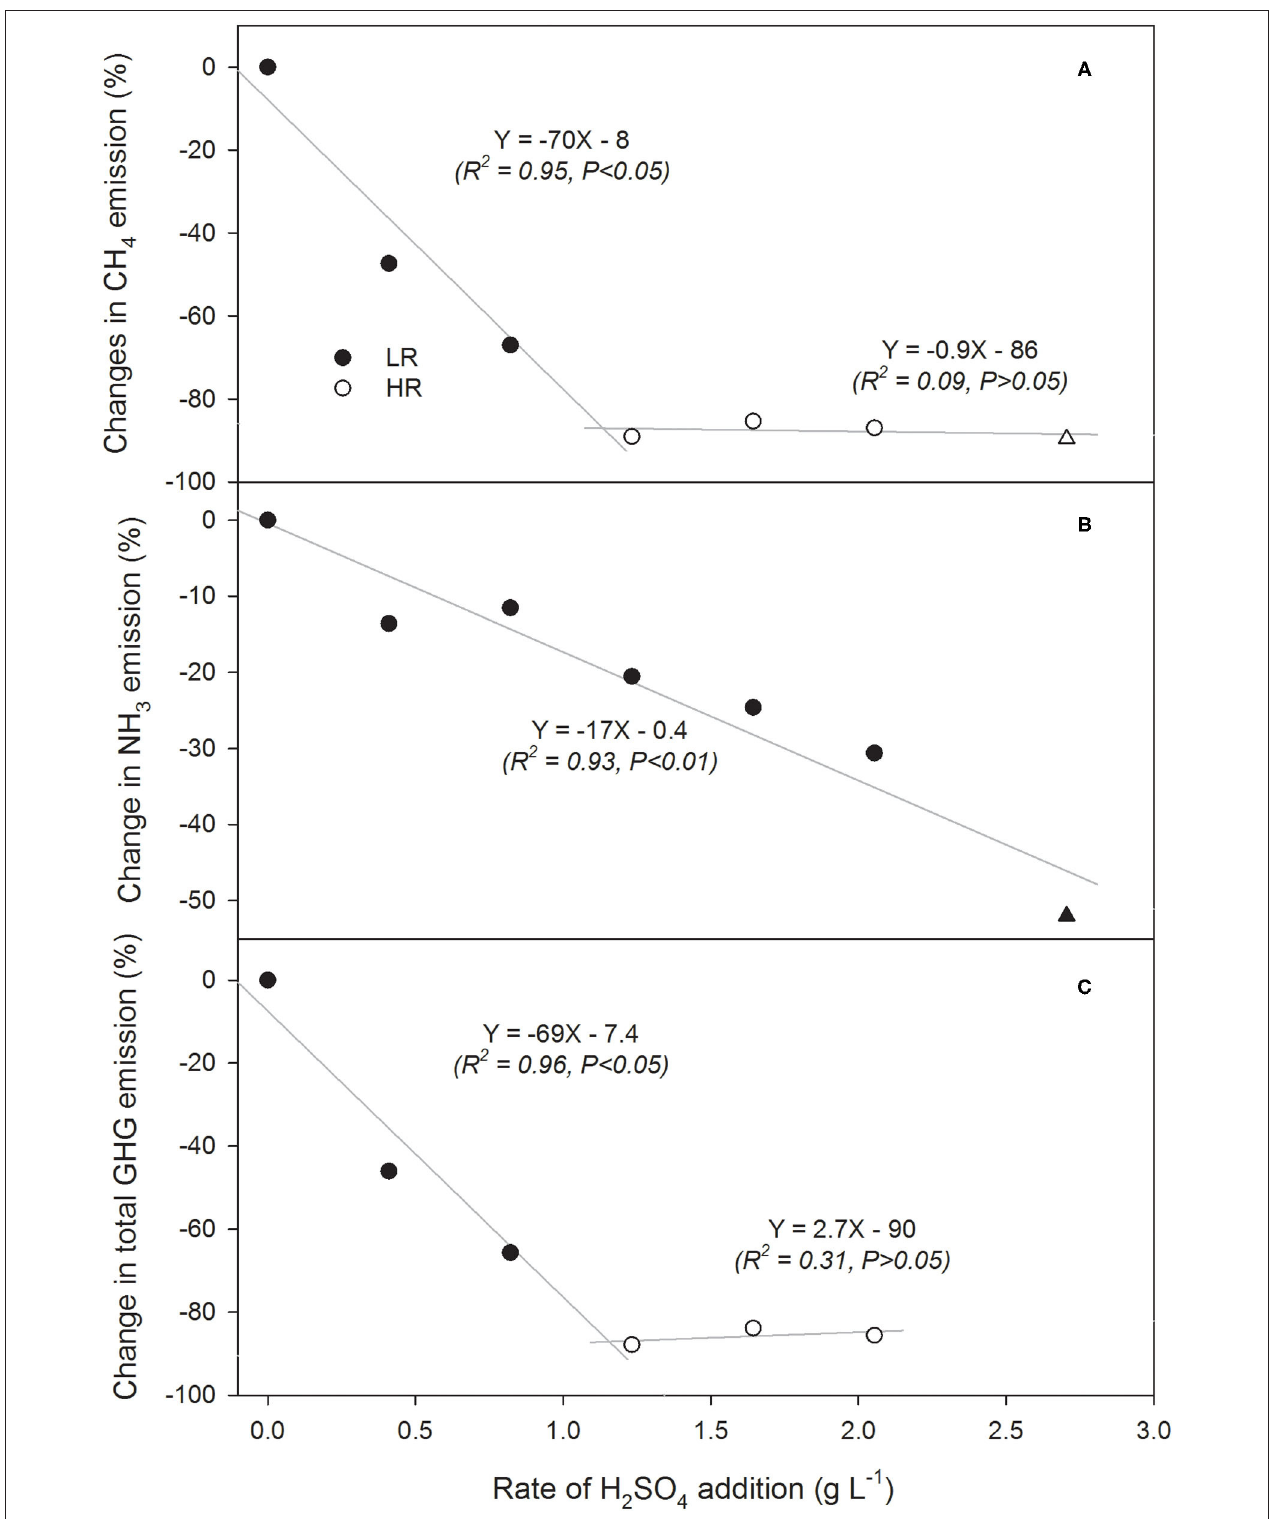
FIGURE 4 | Regression curves showing the relationships between rates of H 2 SO 4 addition to stored dairy slurries and the subsequent changes in (A) CH 4 , (B) NH 3 , and (C) total greenhouse gas emissions (CO 2 -eq). Low rate (LR) and high rate (HR) were separated in (A,C) to show the differing trends. Data from our previous study (Sokolov et al., 2019b) in (A,B) are denoted by 1 and N , respectively. Slopes in the equations indicate expected change (%) in emissions as H 2 SO 4 rate increase with 1g.